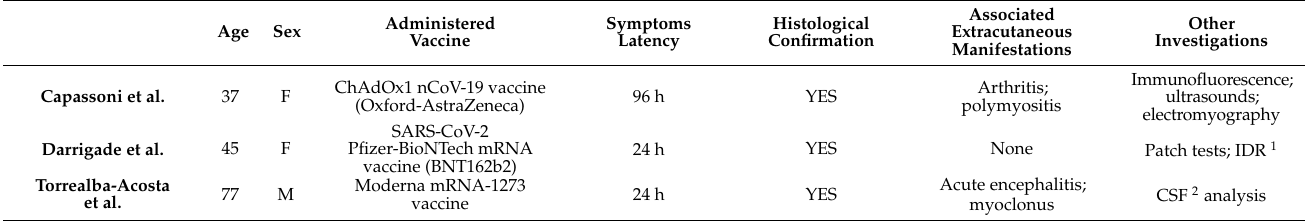
Table 1. Sweet’s syndrome cases reported after Covid-19